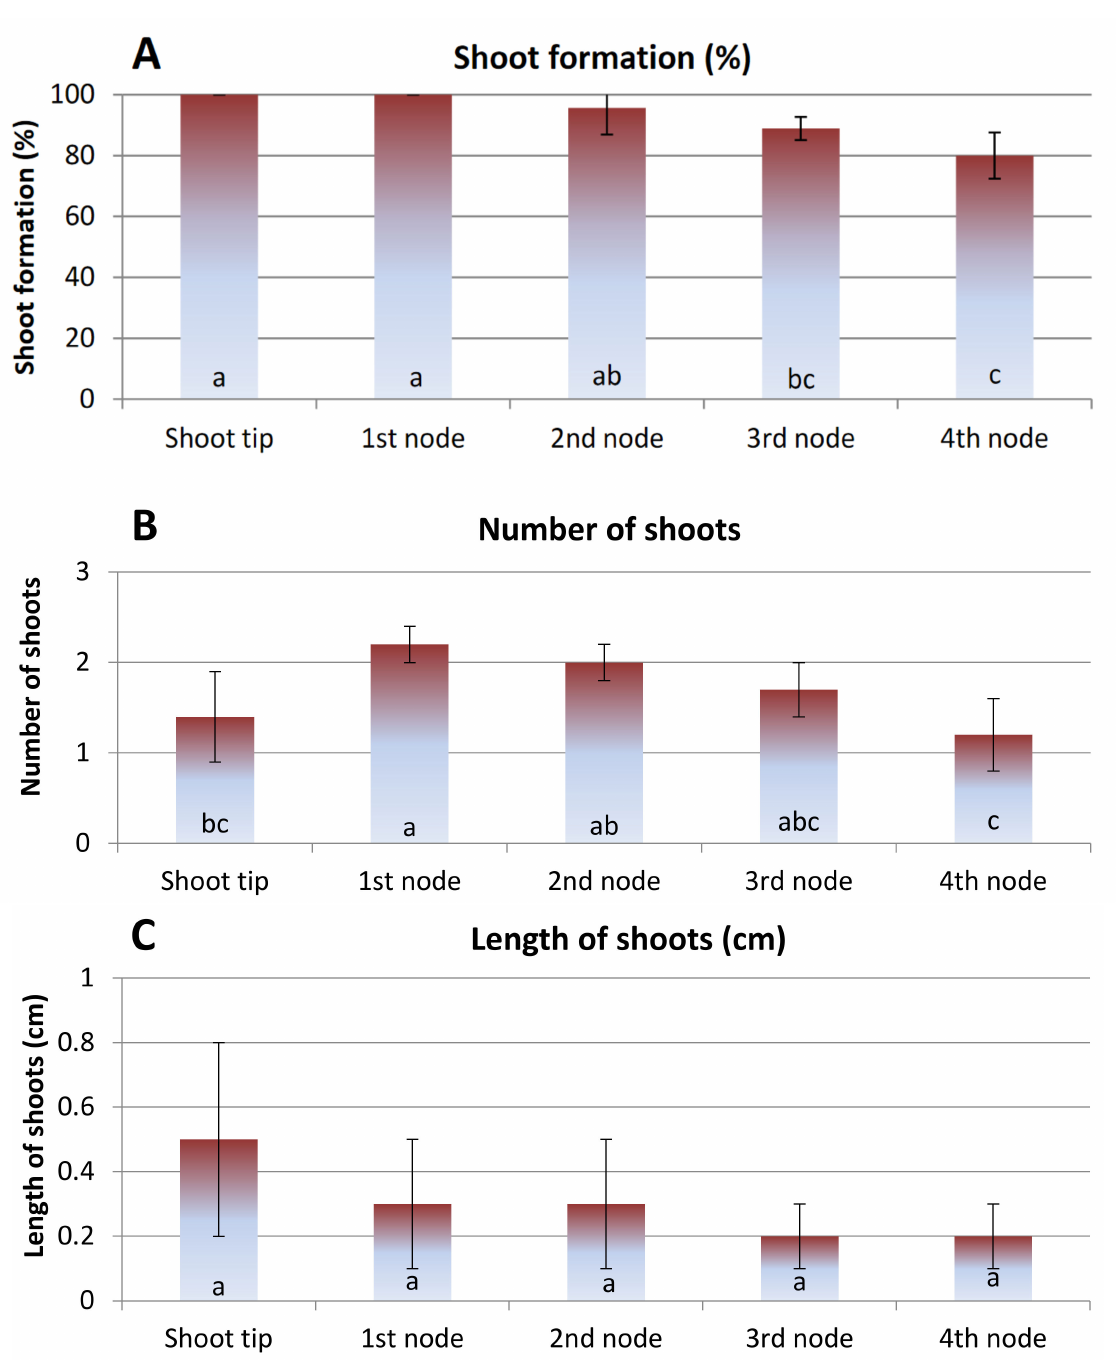
Figure 1. Effect of explant type on ( A ) shoot formation frequency (%), ( B ) number and ( C ) length of shoots of G. jasminoides cultured on agar-solidified MS nutrient medium supplemented with 5 µ M of BAP, after 4 weeks of culture. Bars represent the means ± SD ( n = 45). Bars with different letters are significantly different according to Duncan’s multiple range test at p ≤